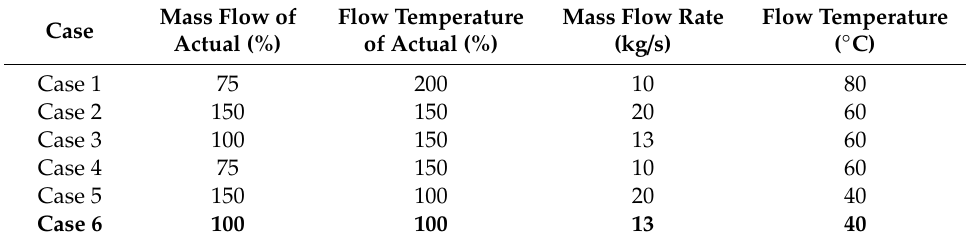
Figure 6. Model layout, consisting of the IDA ICE GHX component, borehole inlets and outlets, input files for supply flow and outdoor air temperature, and logical and mathematical operators for storage operation and energy calculations. Table 1. Combinations of the storage supply flow at heat injection considered in the parametric study, Cases 1–6. Bold print denotes the actual flow (Case 6). Mass flow rate (kg / s) and flow temperature ( ◦ C) are annual mean values.